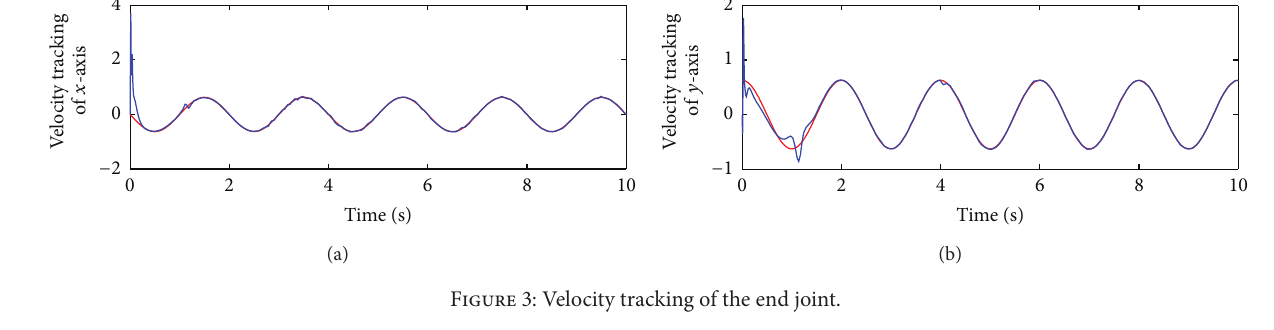
Figure 3: Velocity tracking of the end joint.